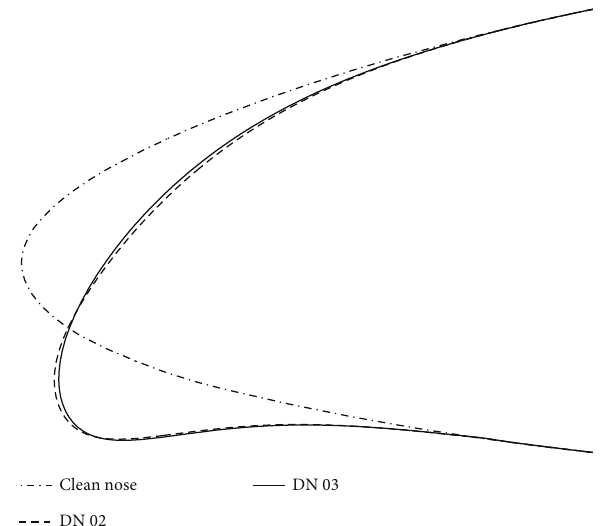
Figure 23: Comparison of droop nose shapes at the wing outboard section.